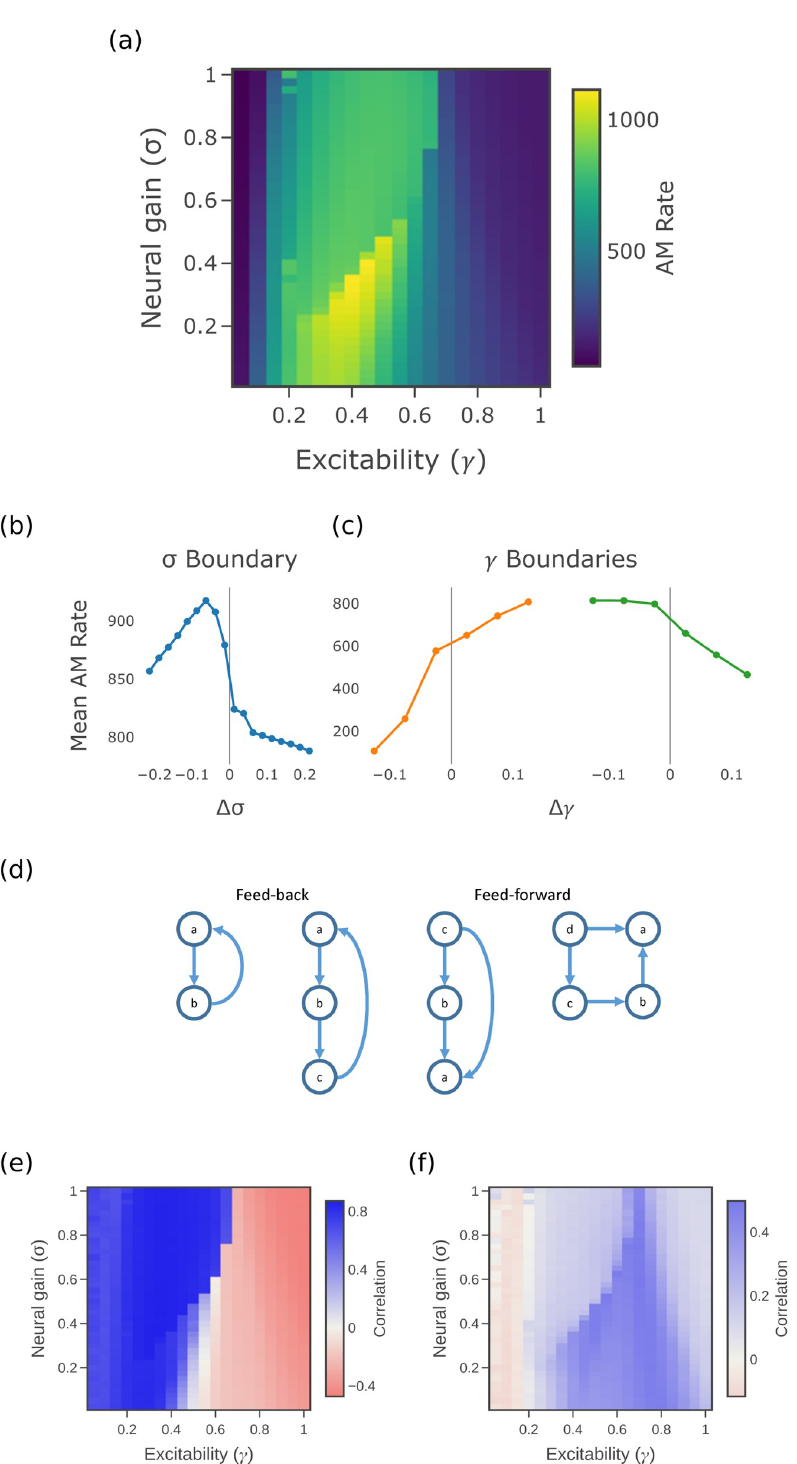
Fig 2. Measures of information storage. (a) Active memory utilization rate. (b) and (c) Mean active memory rate across σ and γ phase boundaries. (d) Network motifs supporting information storage in the dynamics of node a . (e) Correlation of AM rate to local network support (weighted motif counts). (f) Correlation of AM rate to normalized within-region synaptic connection weight. Matching colour scale is used for (e) and (f). By convention we use blue- white-red color scale for correlation plots to emphasise the positive-negative distinction, and default blue-yellow scale for other plots.